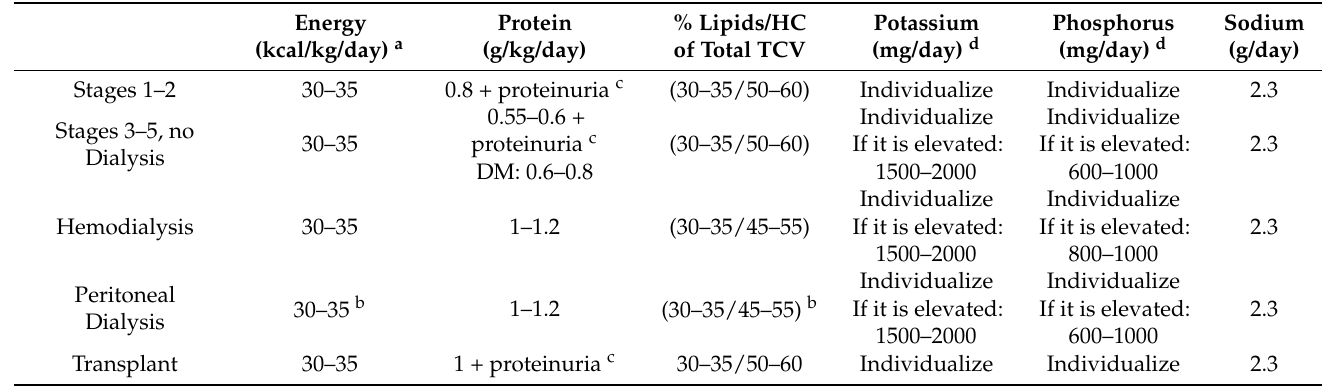
Table 2. Nutritional and protein requirements according to chronic kidney disease stage [11,23].